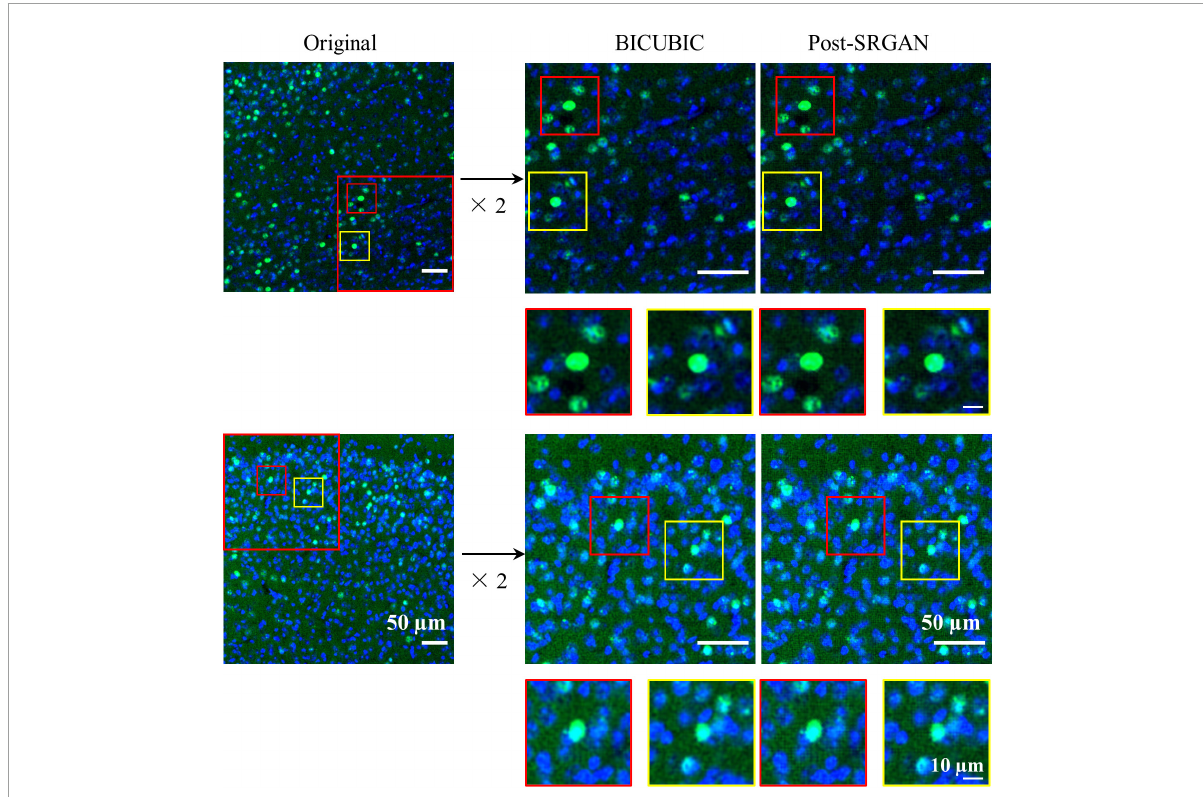
FIGURE3 The images before and after super-resolution generative adversarial network (SRGAN). Left panels represent the original images. Middle panels are the representative BICUBIC images. Right panels show the images of